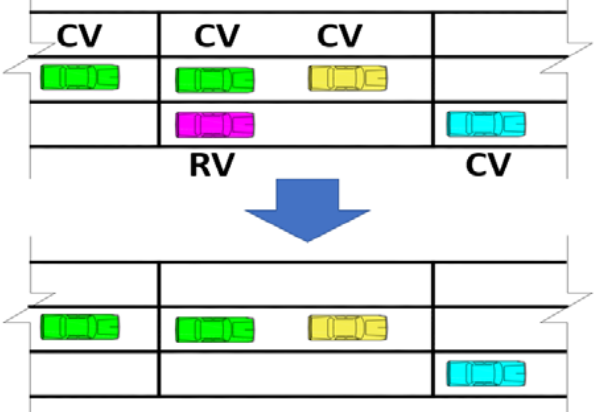
Figure 8. Partial detection.